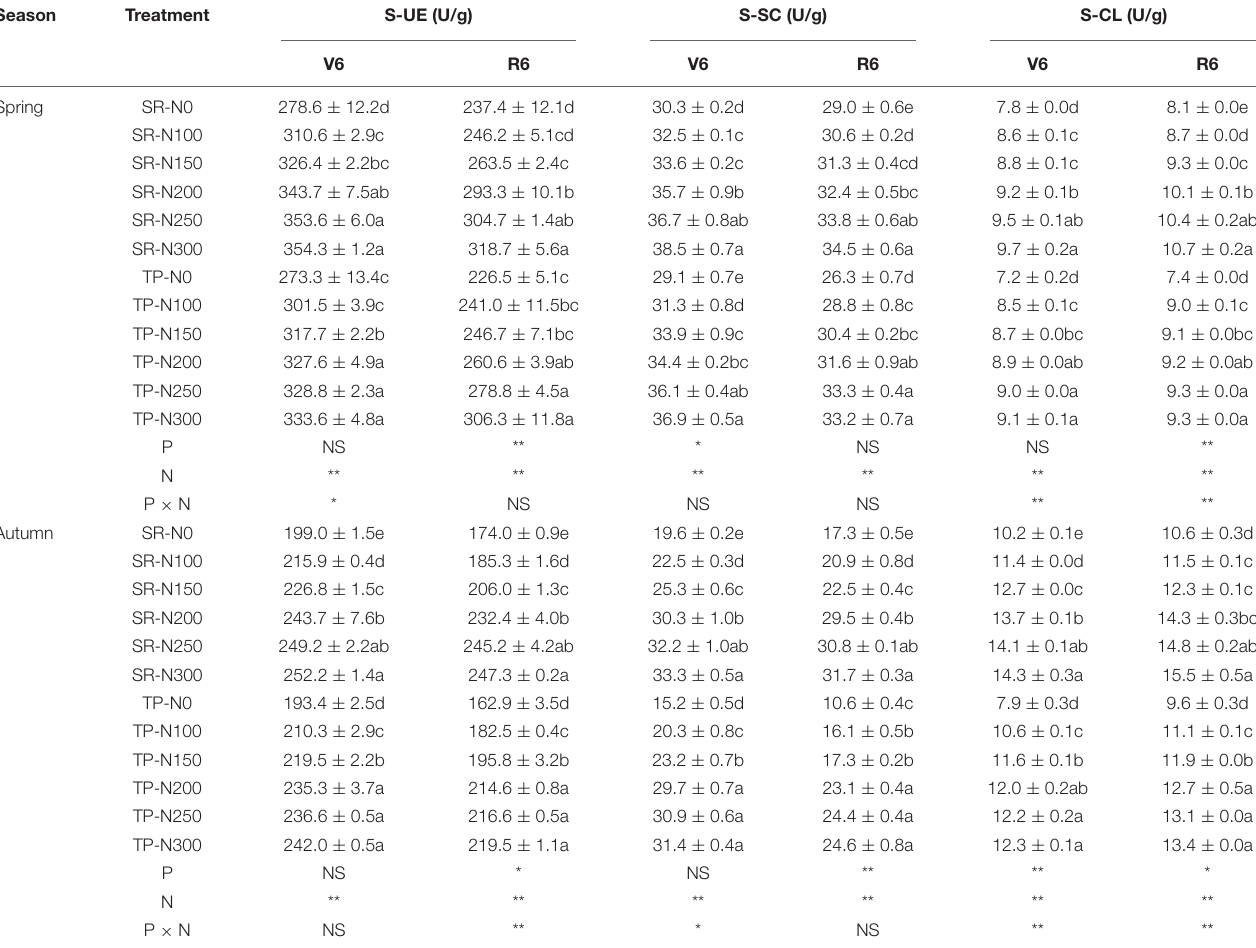
TABLE 1 | Changes in soil enzyme activities with straw returning and nitrogen fertilization under dual-cropping system. Season